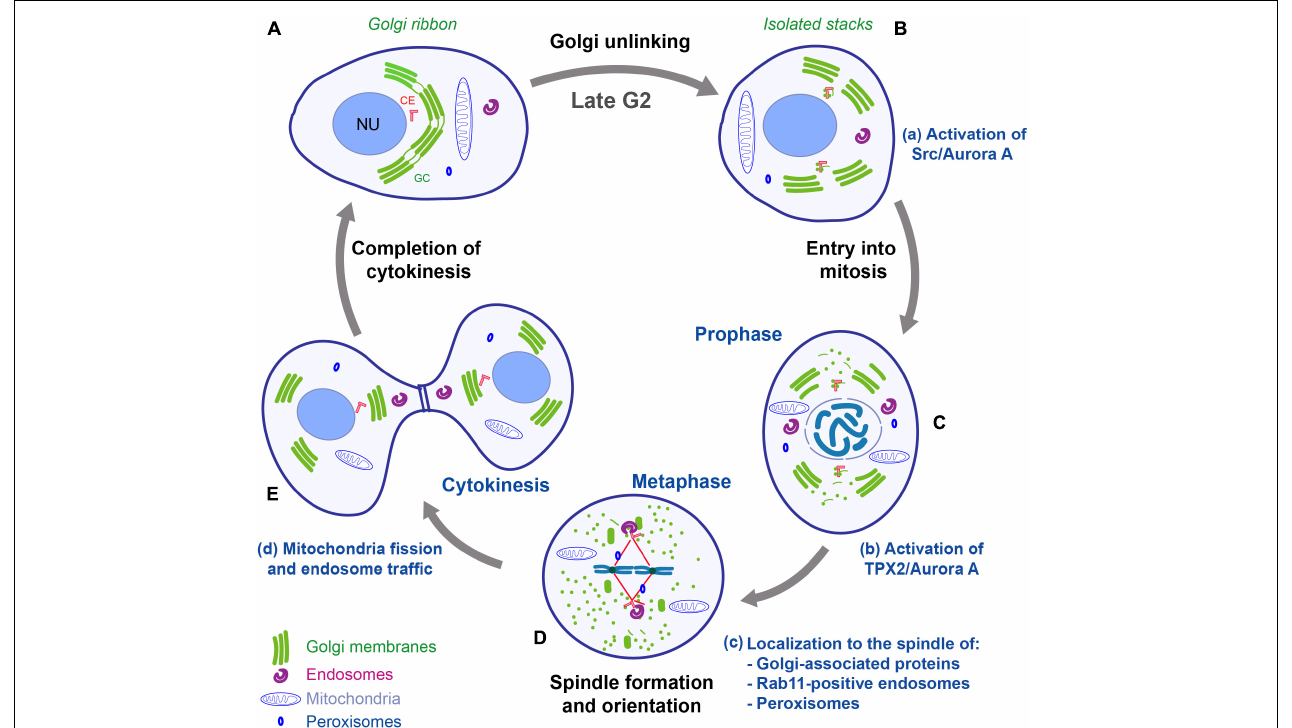
FIGURE 2 | Schematic representation of mitotic redistribution and inheritance of organelles and their connection with the cell cycle. In mammalian cells, during mitosis, the organelles are subjected to complex structural reorganizations. (A,B) During G2, the Golgi ribbon is converted into isolated stacks, and the centrosomes are separated. Golgi unlinking activates a Src/Aurora A signaling pathway that is required for entry into mitosis and centrosome maturation (a) . (C) During prophase, the GC is disassembled into dispersed vesicles and vesicular/tubular clusters; the endosomes, mitochondria and peroxisomes are separated and evenly redistributed in the cell. The disassembly of Golgi stacks allows the release of proteins and the activation of a TPX2/Aurora A pathway that concur to aid the formation of the spindle (b) . (D) During metaphase, several organelle-based protein machineries (e.g., GM130, Rab11 endosomes, and peroxisomes) (c) contribute to organize the formation of the spindle and to achieve correct chromosome alignment at the metaphasic plate. (E) After the formation of the cleavage furrow, the cells are ready to complete the cytokinesis process, which requires mitochondria fission and endosome traffic (d) . Impairment of one of the membrane-based processes can cause several defects in correct completion of mitosis, with potential repercussions on tissue homeostasis and diseases development. CE, centrosome; GC, Golgi complex; NU, nucleus. Adapted with permission from Ayala and Colanzi